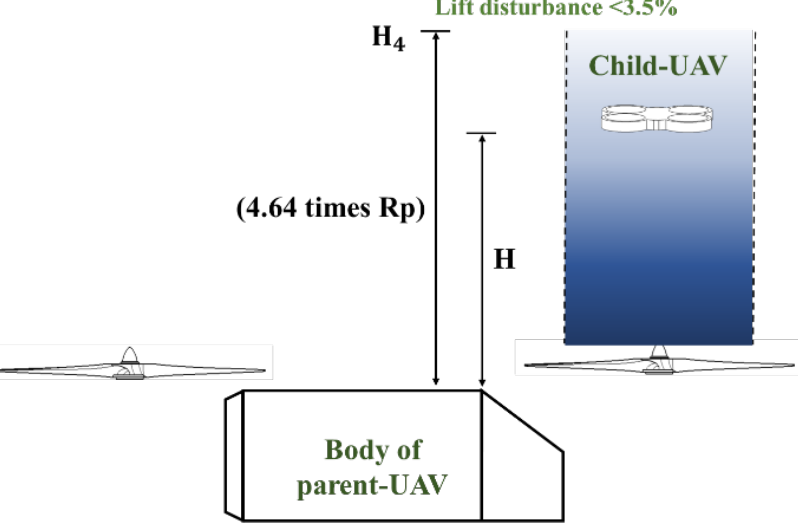
Figure 14. Schematic diagram of the influence extent above a rotor.